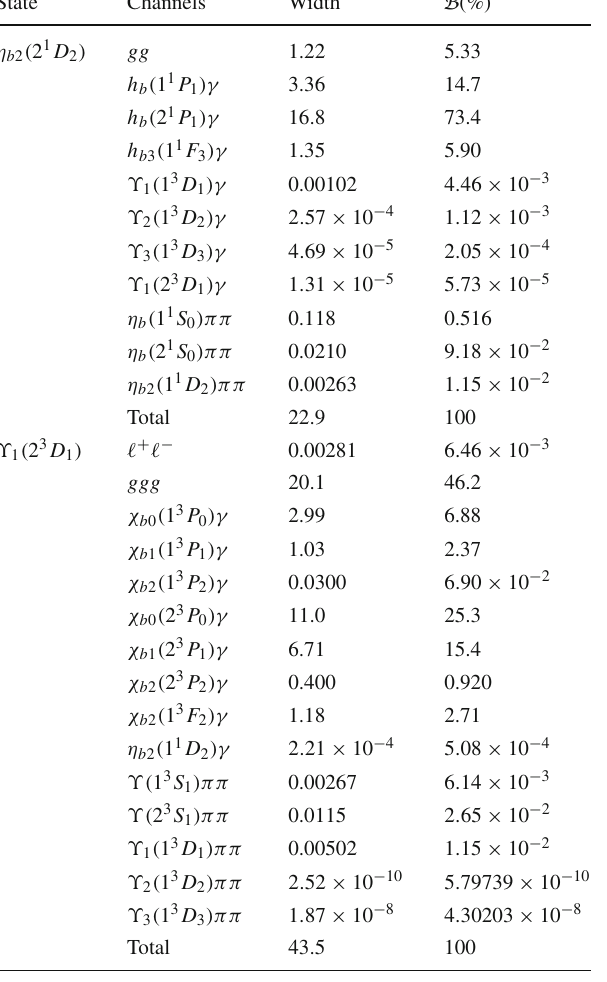
Table 11 Partial widths and branching ratios of annihilation decay, radiative transition, and hadronic transition and total widths for 2 1 D 2 and 2 3 D 1 bottomonium states. The width results are in units of keV State